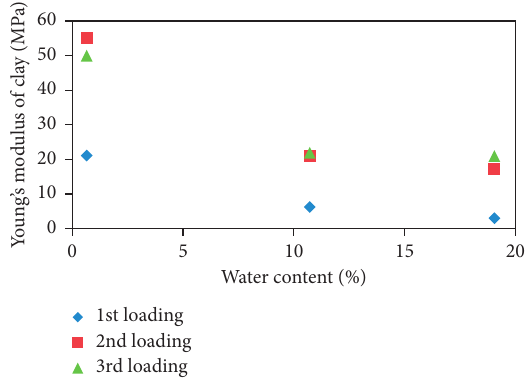
Figure 7: Young’s modulus of the clay specimens at different